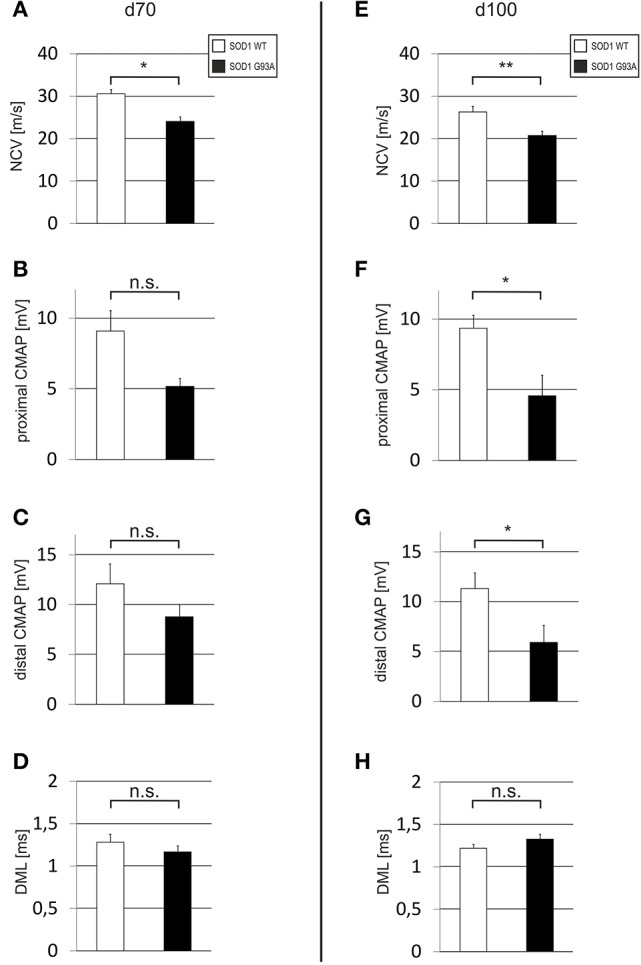
Electrophysiological analysis including NCV, CMAP and DML of the sciatic nerve. Depicted are histograms for d70 (A–D) and for d100 old (E–H) SOD1WT and SOD1 G93A mice (SOD1WT d70 n = 3, SOD1 G93A d70 n = 3, SOD1WT d100 n = 6, SOD1 G93A d100 n = 6). Bar represents means ± SEM; *P < 0.05.; **P < 0.01.